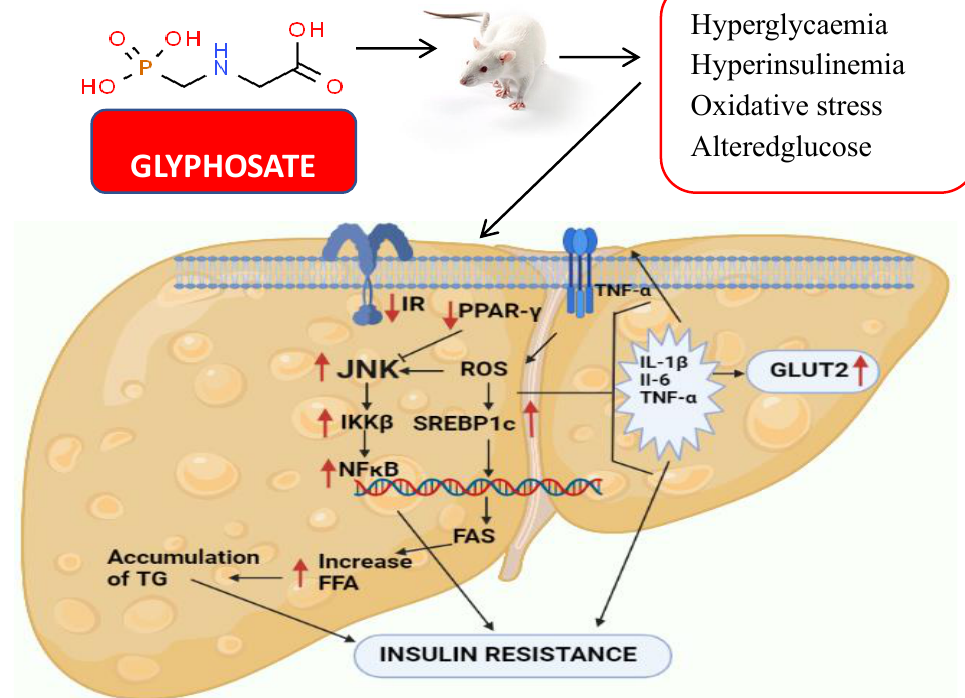
Figure 13. The diagram shows the effect of glyphosate on hepatic insulin signalling and inflamma- tion in male albino rats. Glyphosate exposure results in hyperglycaemia, hyperinsulinemia and oxidative stress in rats that alter the insulin signalling in the liver. Hepatic glucose metabolism was also disturbed as a result, and pro-inflammatory cytokines were increased, leading to NAFLD and insulin resistance.